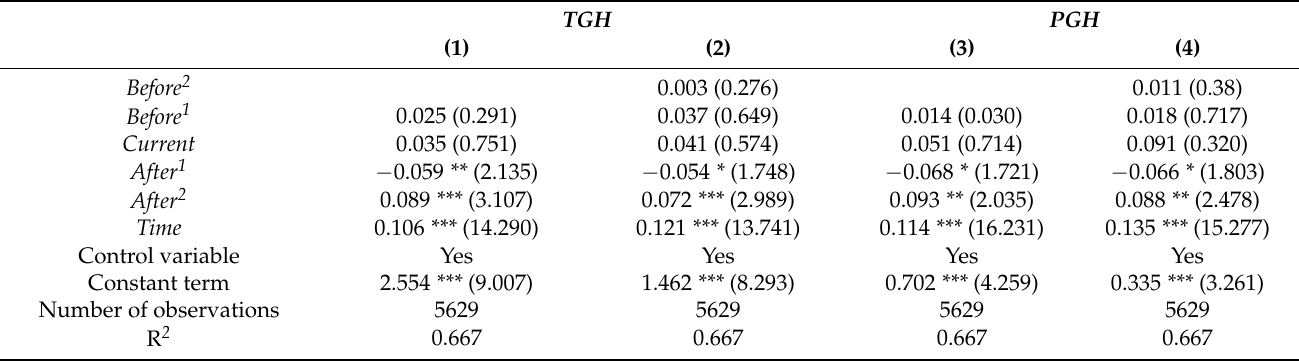
Table 9. Results of the parallel trend test.